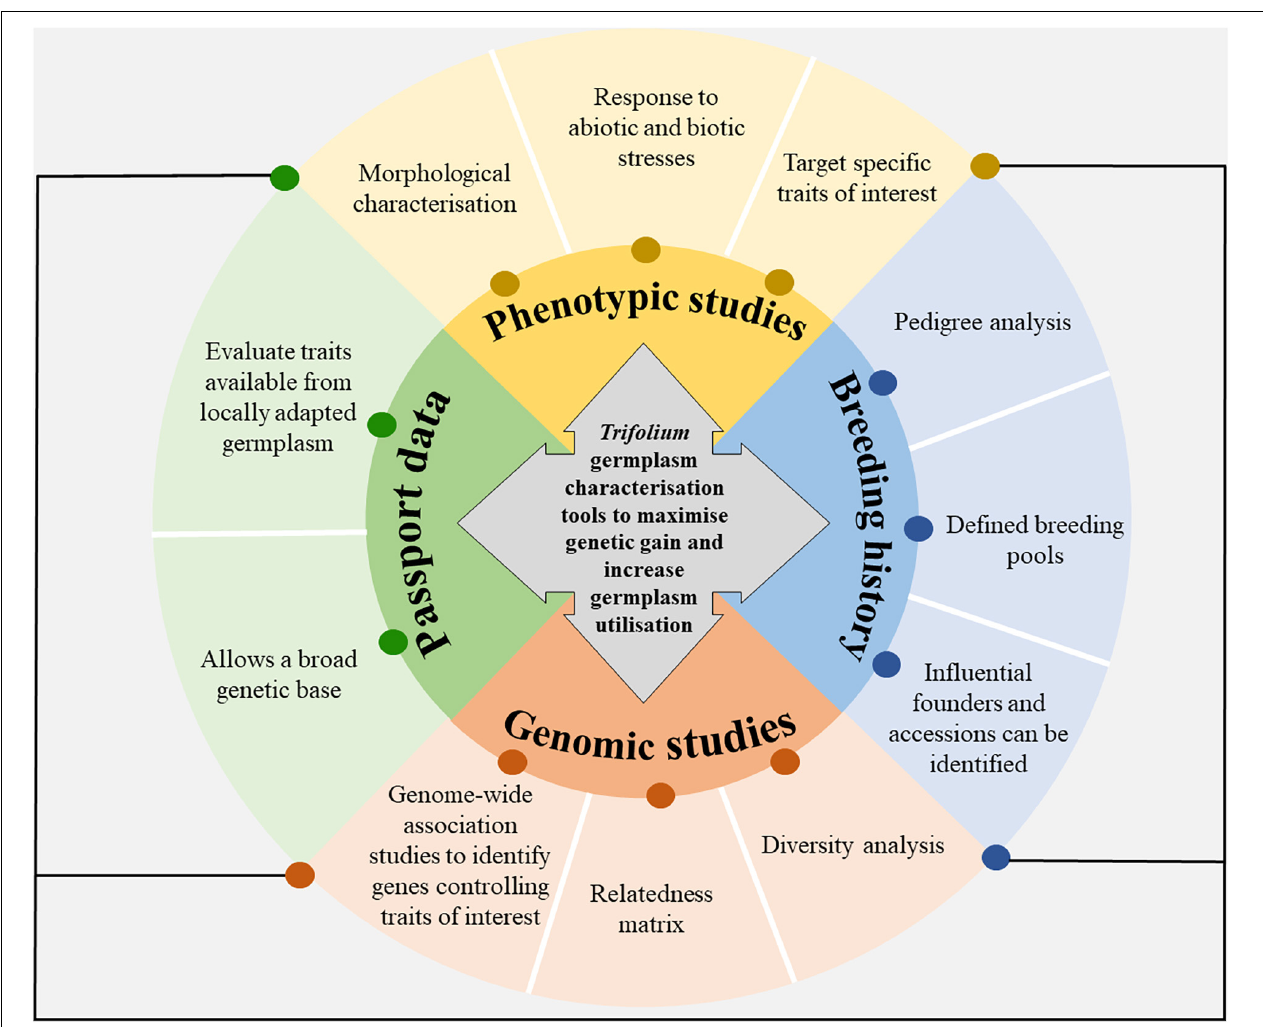
FIGURE 1 | The deep characterisation of germplasm held in gene banks is targeted to increase germplasm utilisation and the flow of germplasm between institutions and countries. Core collections can be developed from the data produced from germplasm characterisation tools. Future management of germplasm banks will require increased germplasm exploration and